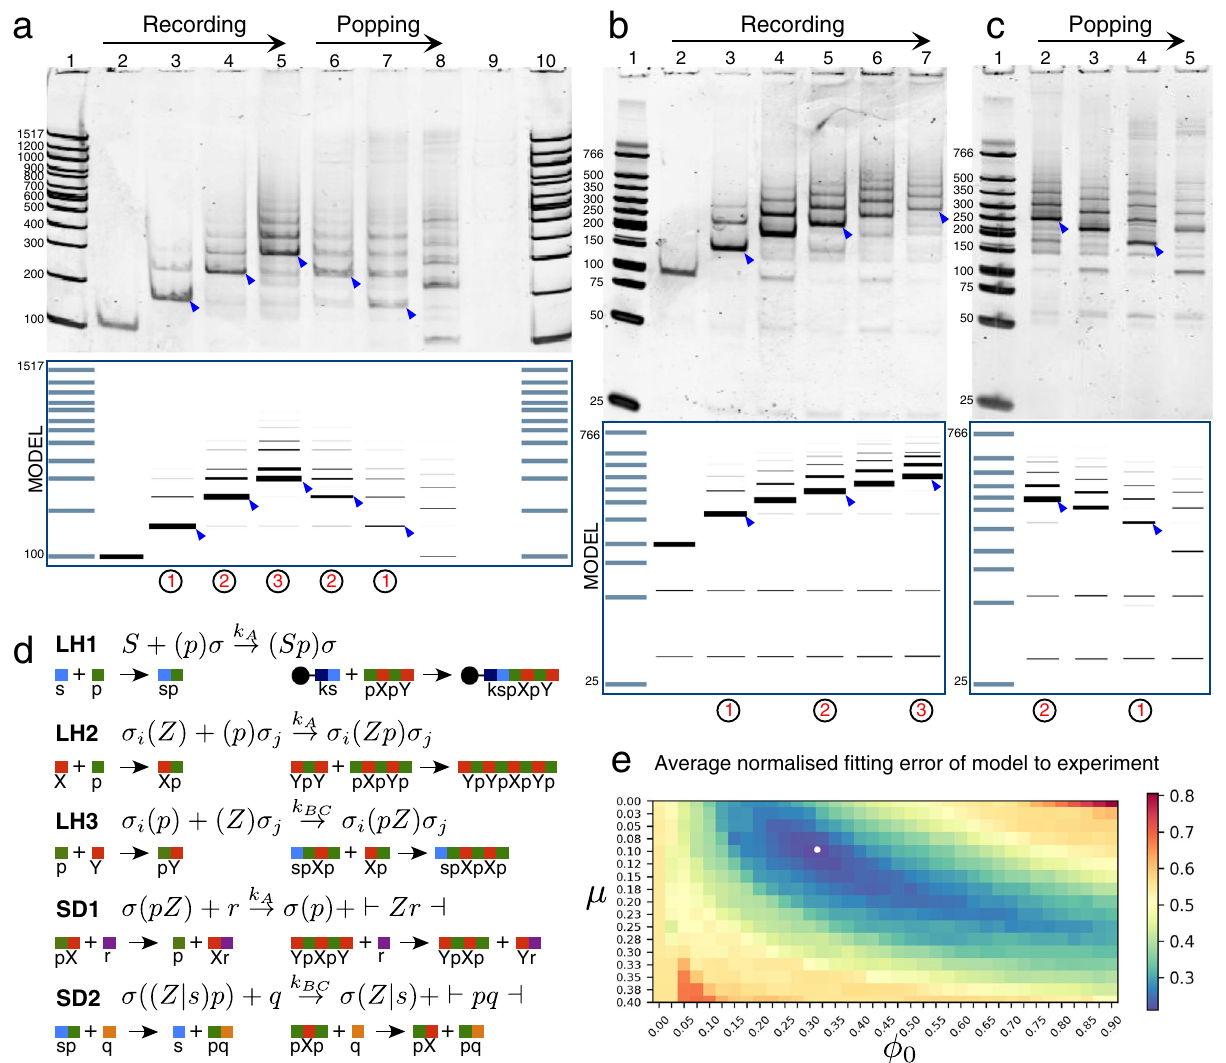
Fig. 2 Experimental results and computational modelling of the DNA stack operated with a single signal type, write . a – c Native PAGE results showing recording and popping up to three write signals. Blue boxes beneath show corresponding predictions of the mass action kinetics computational model. Black circled numbers denote the target number of write signals to be recorded in each lane; small blue arrows on gel images indicate the PAGE migration band corresponding to a stack complex with the target number of write signals. Ladder molecular weight markers in base pairs. Lane reaction sequences in Supplementary Note 3.1. All experiments were repeated independently three times. d Five principle reaction rules of the computational model. For clarity, each rule has two example reactions fi tting the rule drawn underneath (rule notation in Supplementary Note 9). e Collective fi tting of washing parameters μ and ϕ 0 to experimental results in a – c , with white dot denoting lowest average error fi tting at μ = 0.1, ϕ 0 =